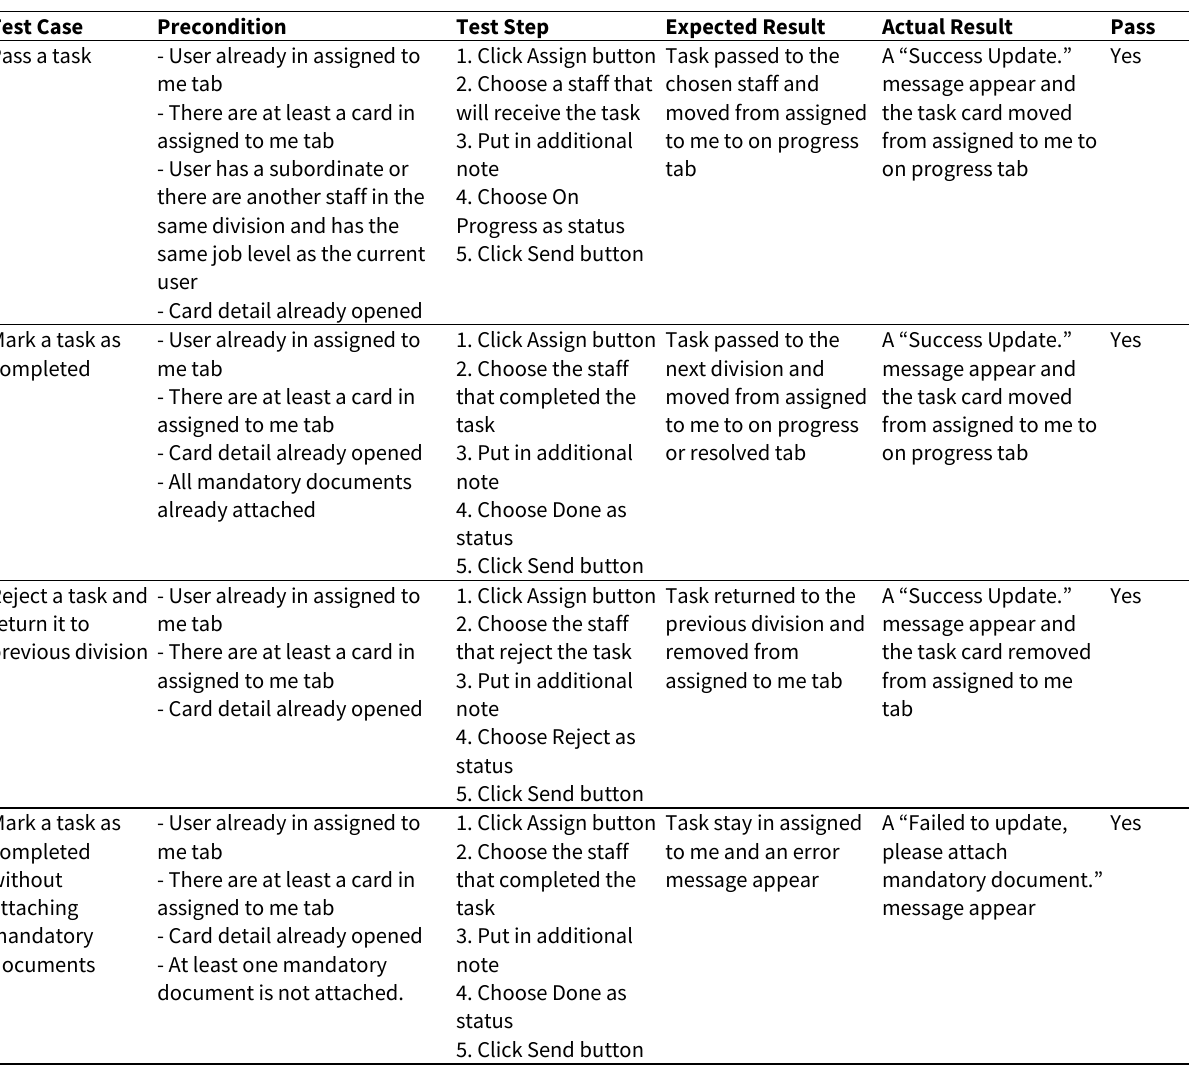
Table 6. Result of